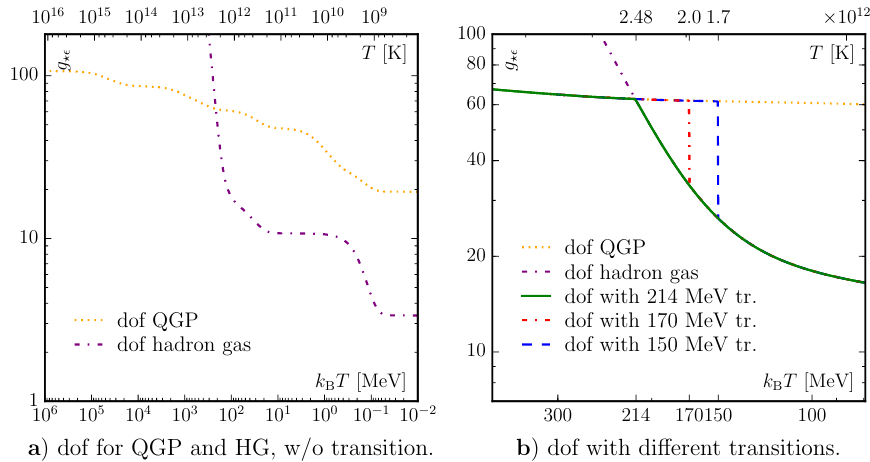
Figure 4. Panel ( a ) shows the effective degrees of freedom (dof) for g ⋆ (cid:101) in the quark-gluon and hadronic phases as functions of temperature. The yellow dotted curve represents the quark-gluon degrees of freedom and the purple dash-dotted curve is for the hadronic equivalent. In panel ( b ), we have zoomed in around the phase transition and plotted g ⋆ (cid:101) for three different transition temperatures: k B T c = 214 MeV in solid green, k B T c = 170 MeV in dash-dotted red, and k B T c = 150 MeV in dashed